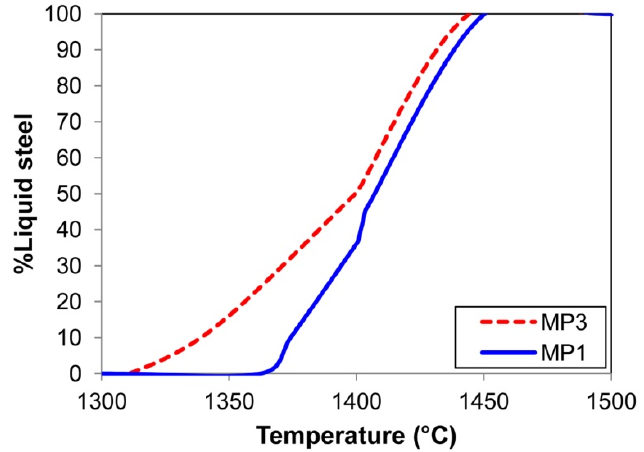
Figure 4. Cu-Al phase diagram (FactSage 7.3).